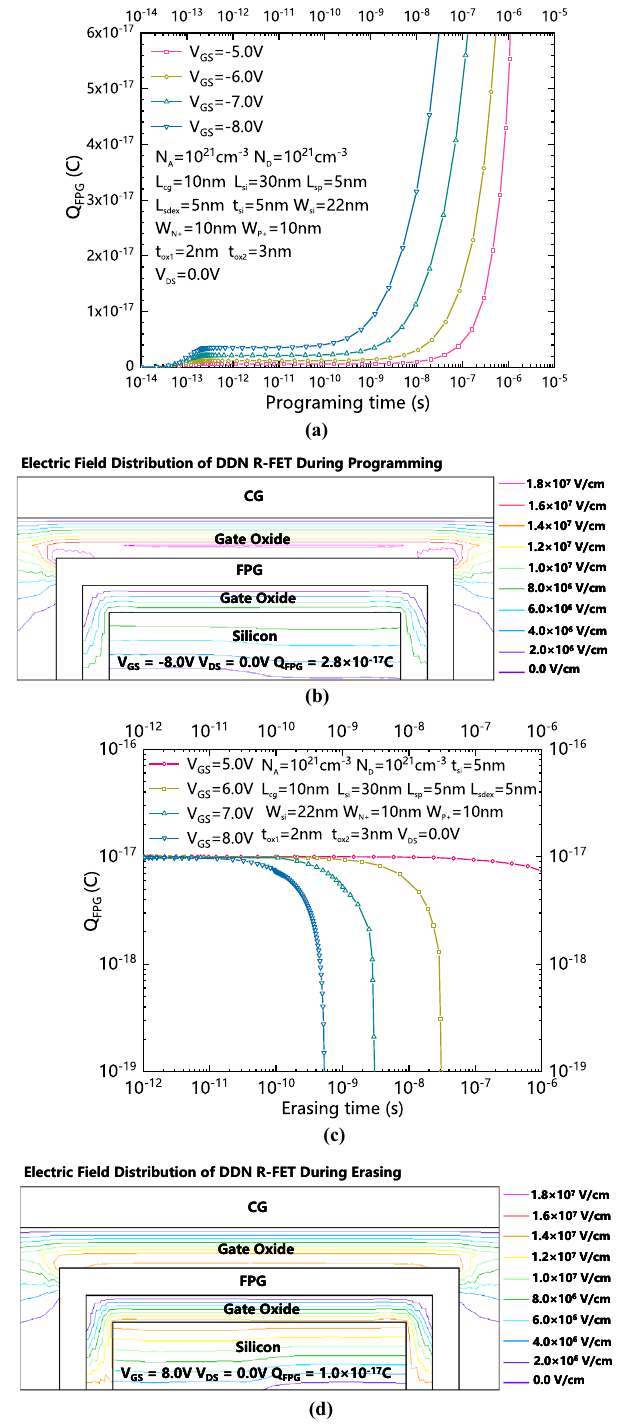
Figure 2. ( a ) The dependence between Q FPG and programming time under different V GS s. ( b ) The electric field distribution of DDN R-FET during programming with a − 8 V V GS . ( c ) The dependence between Q FPG and erasing time with different V GS s with an initial Q FPG . ( d ) The electric field distribution of DDN R-FET during erasing with an 8 V V GS